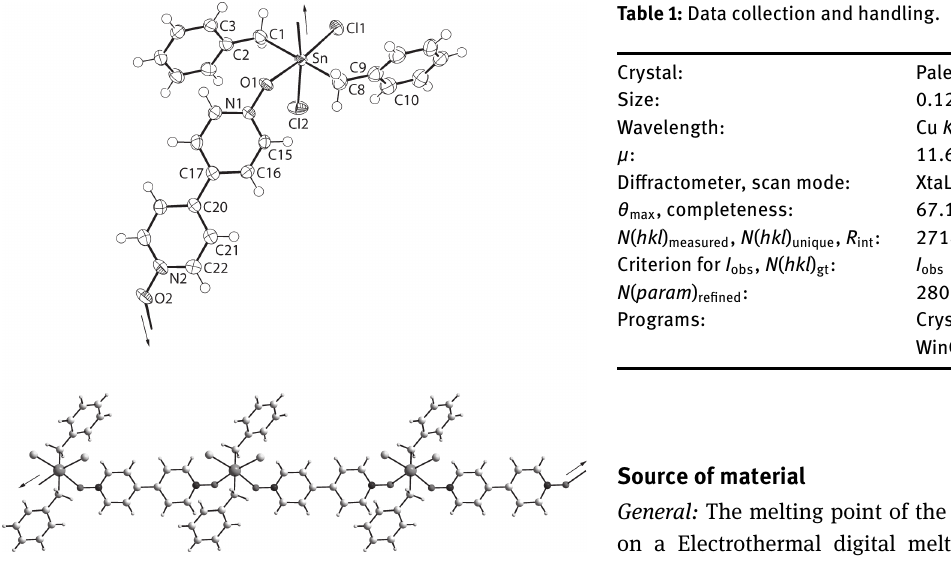
Table 1: Data collection and